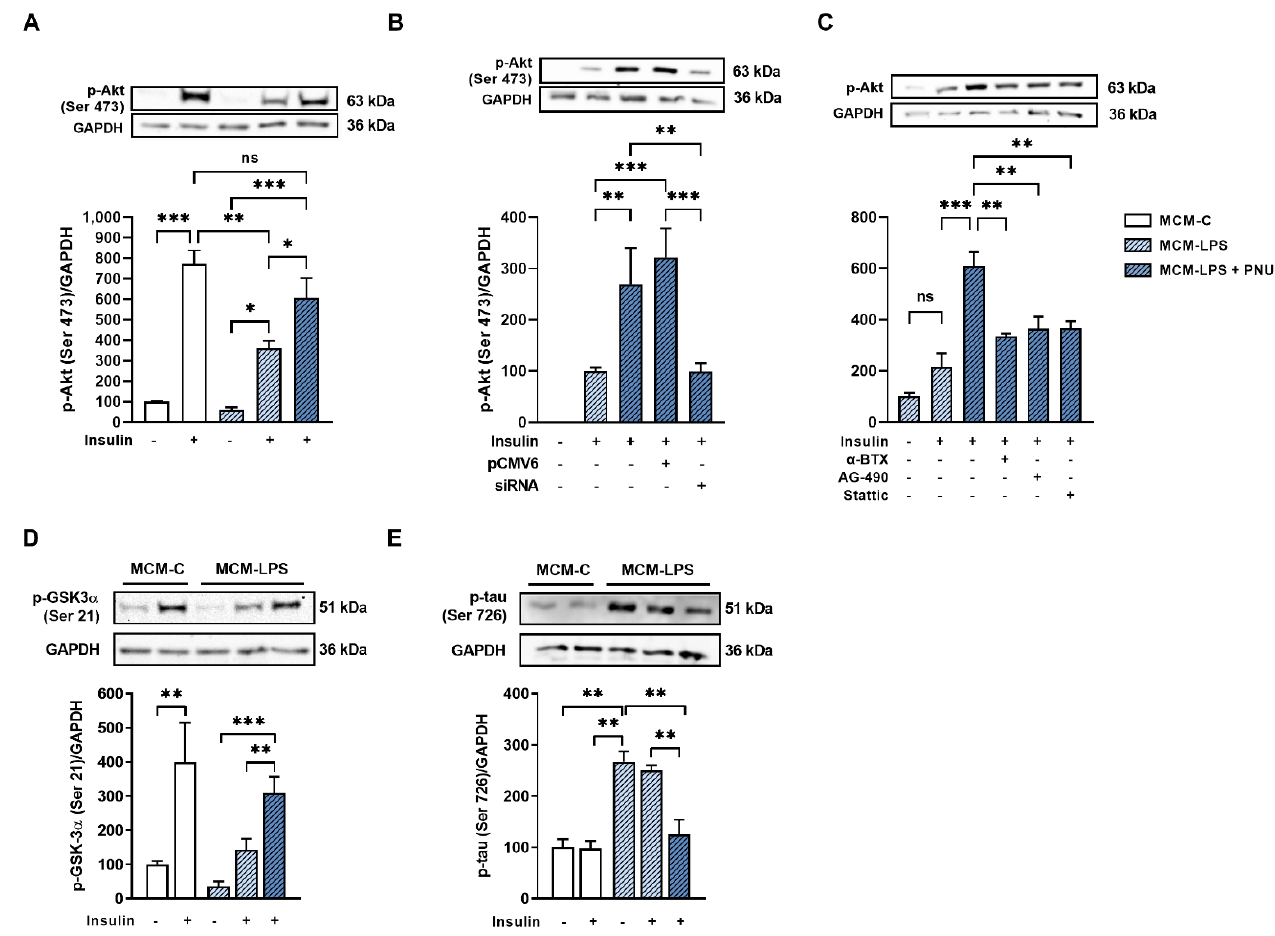
Figure 6. α 7nAchR prevents insulin resistance and GSK-3/tau activation in neurons. mHypoA-2/29 cells were incubated for 6 h with MCM-C or MCM-LPS and treated with insulin (100 nM) for 10 min. A stimulus with PNU-282987 (1 µ M) was performed 15 min before and 3 h after the addition of the conditioned medium. ( A – C ) Akt phosphorylation levels were assessed by Western blot ( A ); in some groups, cells were previously transfected with α 7nAchR overexpression plasmid or siRNA ( B ) or treated with α -bungarotoxin (100 µ M; 1h), Stattic (30 µ M; 30 min), and AG-490 (100 µ M; 30 min) ( C ) before the first PNU-282987 stimulus. ( D , E ) Western blot analysis of ( D ) GSK3 and ( E ) tau phosphorylation levels. * p < 0.05, ** p < 0.01, *** p < 0.001, n = 3.